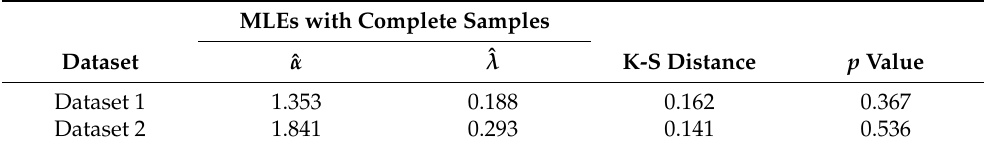
Table 9. The K-S distance and MLEs of the two datasets. MLEs with Complete Samples